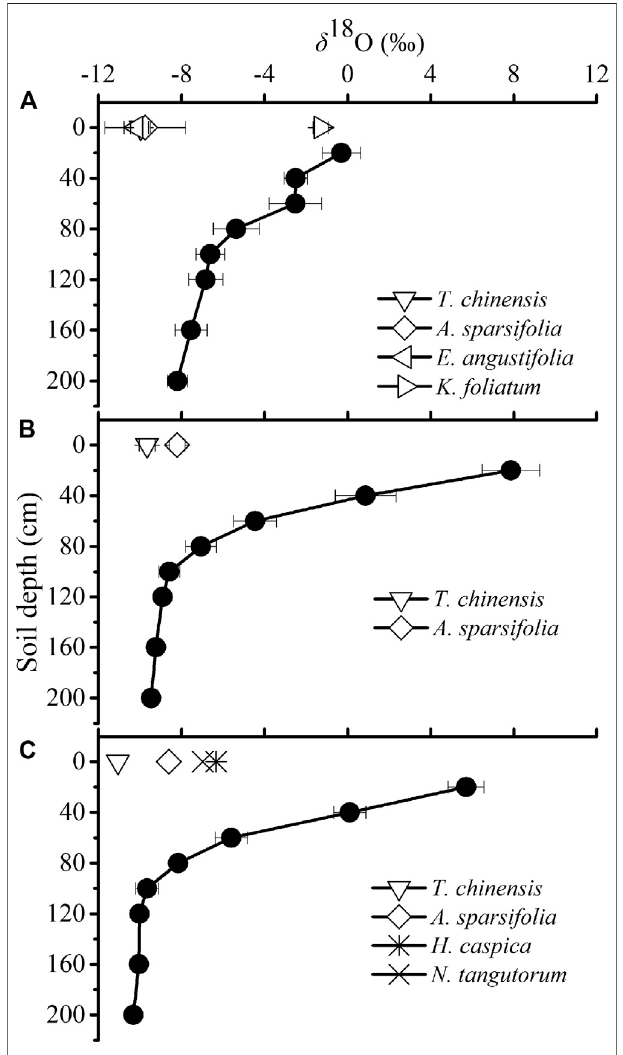
FIGURE4| Variationinthe δ 18 Ovalueofsoil waterinthesalinesite1 (A) , saline site 2 (B) and saline site 3 (C) . Xylem water δ 18 O values of the dominant species are also presented in each saline site. Data are presented as mean ± 1